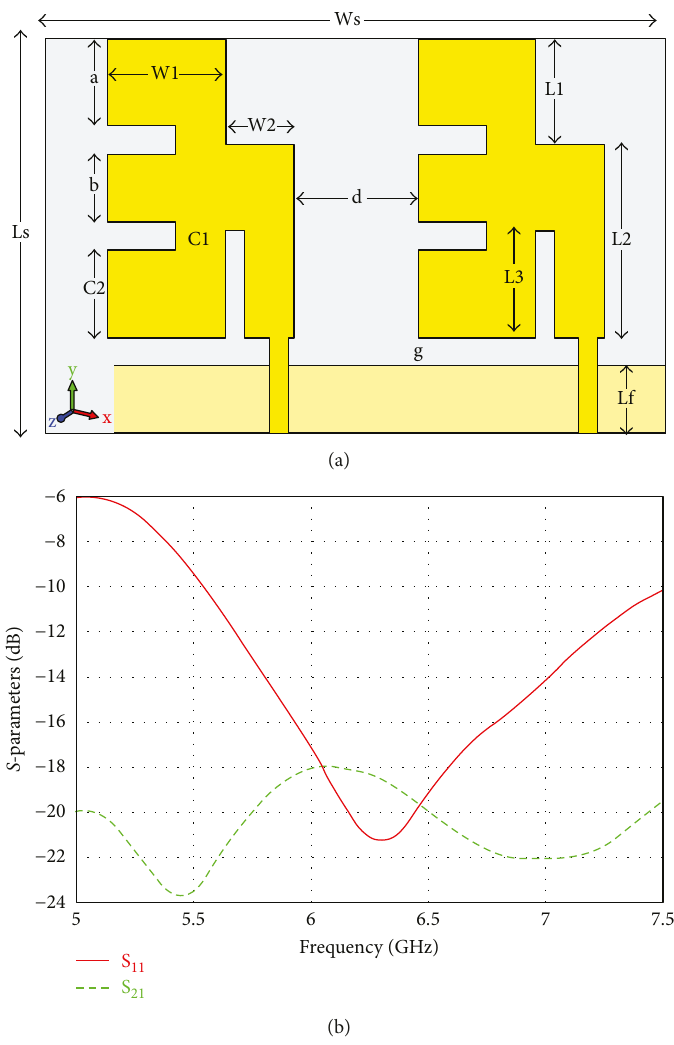
Figure 1: (a) The proposed MIMO system and (b) S